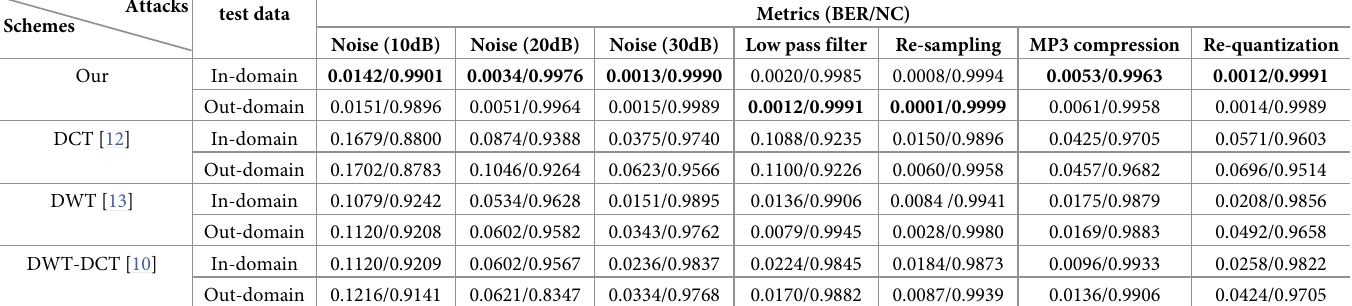
Table 2. Robustness comparison of the proposed scheme and other zero-watermarking schemes under common attacks, where �� / �� indicates average metrics BER/ NC and the bold mark indicates the best number across all the schemes under each attack.